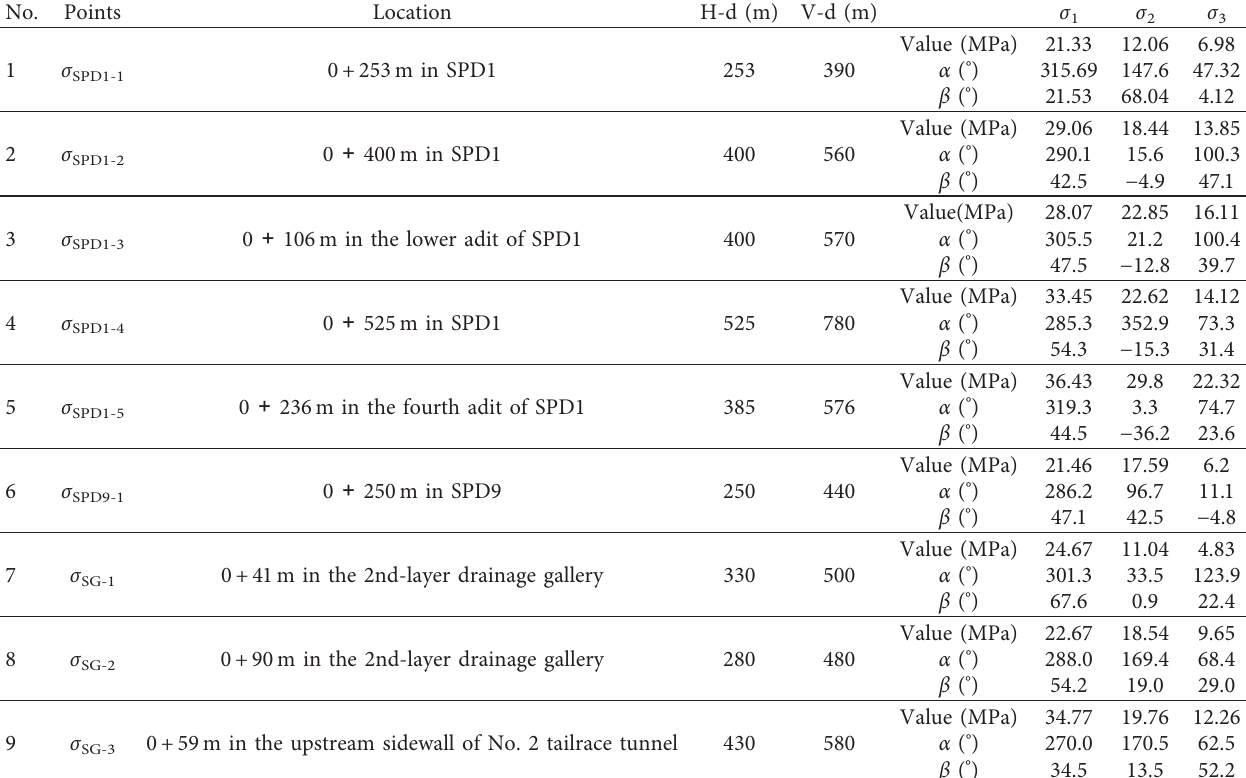
Table 1: The results of in situ stress measurements around the Houziyan underground powerhouse.